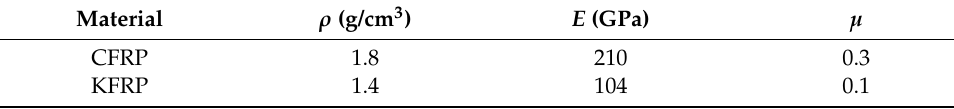
Table 2. Material properties of CFRP and KFRP.